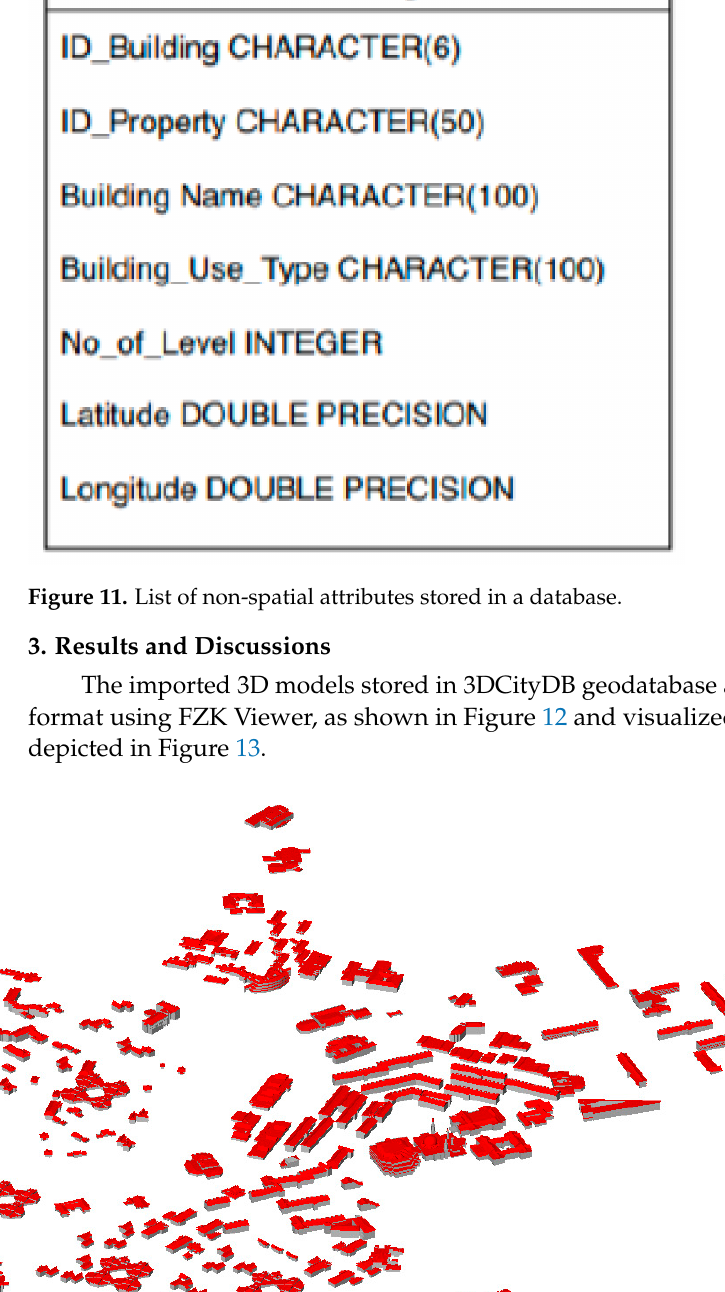
Figure 13. Virtual 3D campus of Universiti Teknologi Malaysia as displayed in Cesium. The first phase of this study consisted of 3D modeling based on aerial photos and site visits. The building footprint was generated from aerial photos, while the wall and roof surfaces were drawn based on on-site visit observations. Therefore, the resulting 3D build-